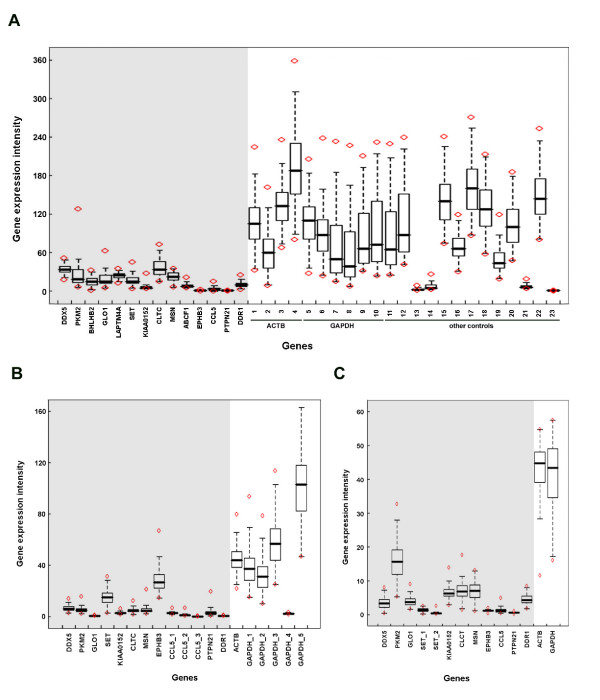
Bootstrap box plots of the gene expression intensity of various internal controls. (A) The box plot results show the best 14 internal control candidates, all of which exhibited consistent expression intensity in the NHRI lung adenocarcinoma microarray dataset for each re-sampling process. Moreover, also included are 10 well-known Q-RT-PCR internal controls contained in 23 probe sets on the HG-U133A chip. These are shown as #1–23 in x-axis. The detailed probe set characteristics were shown in Table 1. Except ABCF1, BHLHB2 and LAPTM4A, the gene expression intensities of top 12 internal control candidates, GAPDH, and ACTB from the Boston (B) and the Ann Arbor lung cancer datasets (C) were also compared. DDX5: (DEAD (Asp-Glu-Ala-Asp) box polypeptide 5), PKM2: (pyruvate kinase, muscle), BHLHB2: (basic helix-loop-helix domain containing, class B, 2), GLO1: (glyoxalase I), LAPTM4A: (lysosomal-associated protein transmembrane 4 alpha), SET: (SET translocation (myeloid leukemia-associated)), CLTC: (clathrin, heavy chain (Hc)), MSN: (MSN/ALK fusion; moesin/anaplastic lymphoma kinase fusion protein), ABCF1: (ATP-binding cassette, sub-family F (GCN20), member 1), EPHB3: (EPH receptor B3), CCL5: (chemokine (C-C motif) ligand 5), PTPN21: (protein tyrosine phosphatase, non-receptor type 21), DDR1: (discoidin domain receptor family, member 1), 1–4: ACTB (actin, beta), 5–6: B2M (beta-2-microglobulin), 7–12: GAPDH (glyceraldehyde-3-phosphate dehydrogenase), 13: HMBS (hydroxymethylbilane synthase), 14: HPRT1 (hypoxanthine phosphoribosyltransferase 1), 15–19: RPL13A (ribosomal protein L13a), 20: RPL32 (ribosomal protein L32), 21: SDHA (succinate dehydrogenase complex, subunit A, flavoprotein (Fp)), 22: UBC (ubiquitin C), 23: YWHAZ (tyrosine 3-monooxygenase/tryptophan 5-monooxygenase activation protein, zeta polypeptide).